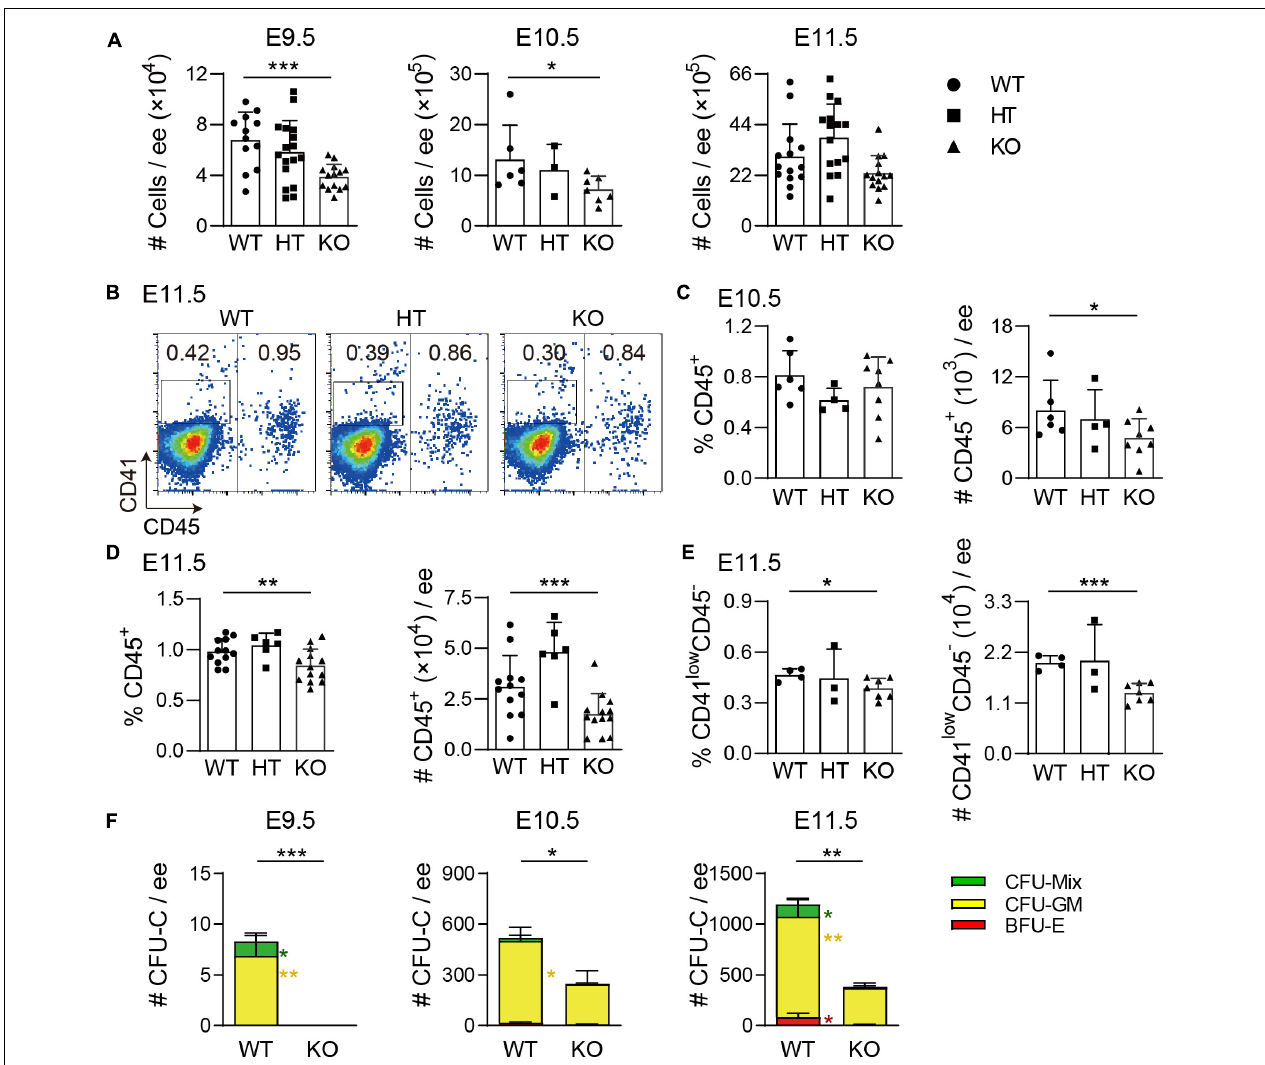
FIGURE 1 | Wip1 deficiency results in the reduction of hematopoietic progenitor cell number in the embryonic head. (A) The reduction of the total numbers in the E9.5–E11.5 embryonic head. E9.5, n = 5; E10.5, n = 3; E11.5, n = 8; * p < 0.05, *** p < 0.001. (B) Representative flow cytometry analysis of CD41 low CD45 − and CD45 + cells in the E11.5 embryonic head. (C,D) The percentages and absolute numbers of CD45 + cells in the E10.5–E11.5 embryonic head. E10.5, n = 3; E11.5, n = 6; * p < 0.05, ** p < 0.01, *** p < 0.001. (E) The percentage and absolute number of CD41 low CD45 − cells in the E11.5 embryonic head. n = 3; * p < 0.05, *** p < 0.001. (F) Colony-forming unit-culture (CFU-C) assays showed the number of CFU-Cs in the E9.5–E11.5 embryonic head. Numbers of colony type are indicated by bar color. E9.5, n = 3; E10.5, n = 2; E11.5, n = 4; * p < 0.05, ** p < 0.01, *** p < 0.001.